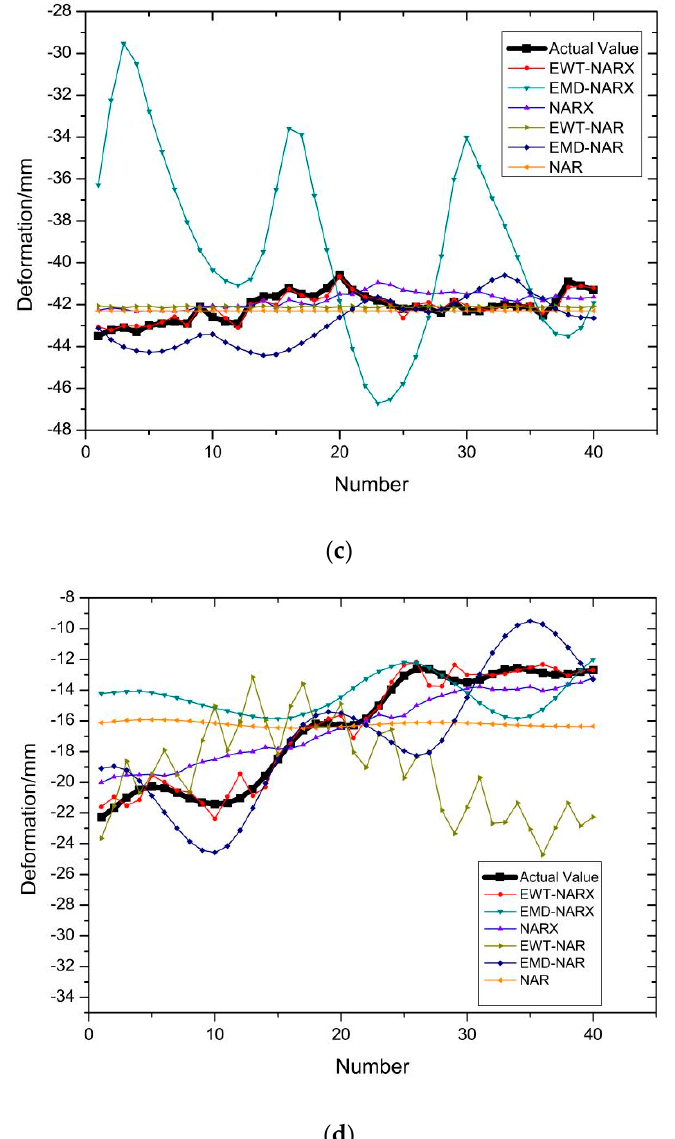
Figure 8. The prediction results of different models at each point: ( a ) The prediction results of point KD62; ( b ) the prediction results of point ZD13; ( c ) the prediction results of point KD25; ( d ) the prediction results of point ZD49. Table 1. The reduction ratio of each model compared to EWT-NARX.